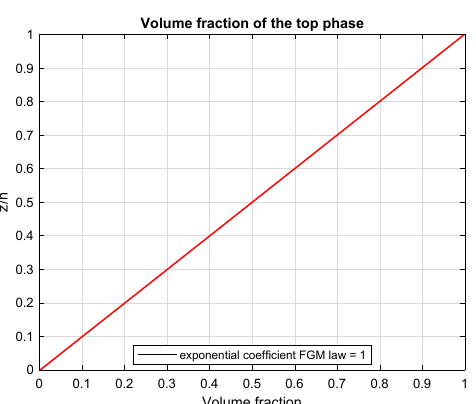
Figure 5. Second benchmark, volume fraction of the ceramic phase for a simply supported cylinder with one FGM ( p = 1) layer.